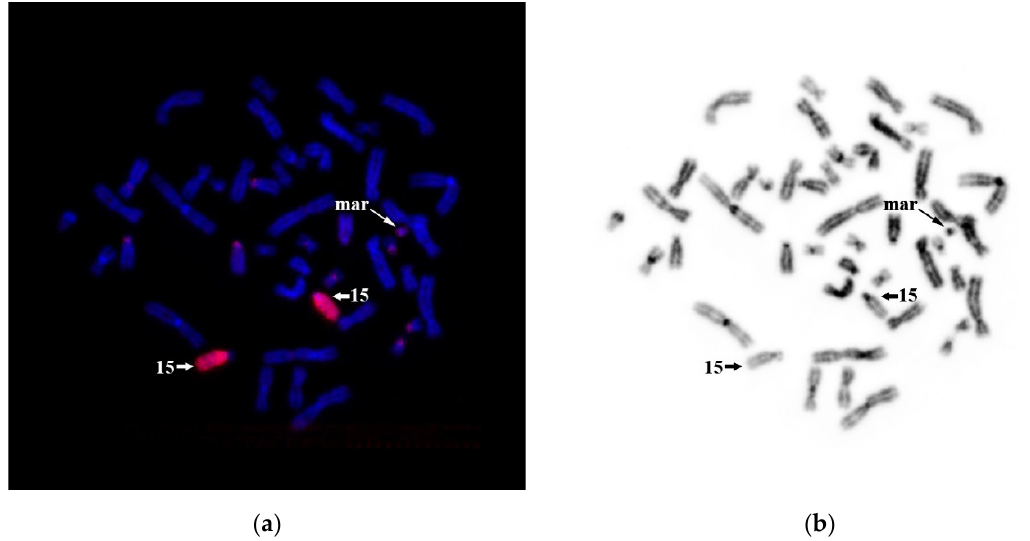
Figure 12. CISS hybridization with WCP15 DNA probe on the patient’s metaphase chromosomes. ( a ) WCP15 DNA probe-stained chromosome 15 (red). A weak signal in nucleolar organizer regions (NORs) of acrocentric chromosomes. ( b ) Inverted DAPI banding. No. 15—indicates the homologs of chromosome 15. mar—indicates sSMC.